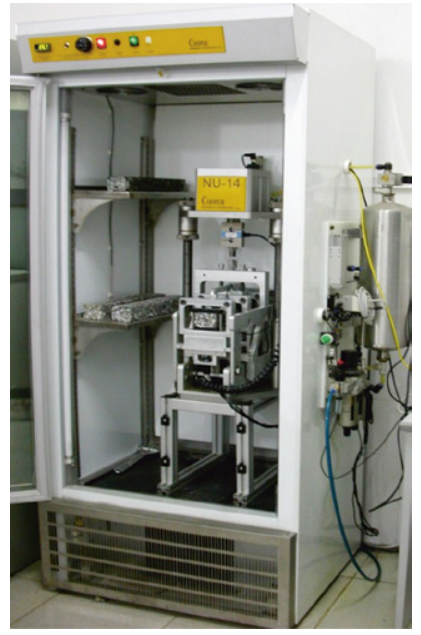
Figure 6. Four-point bending-beam fatigue